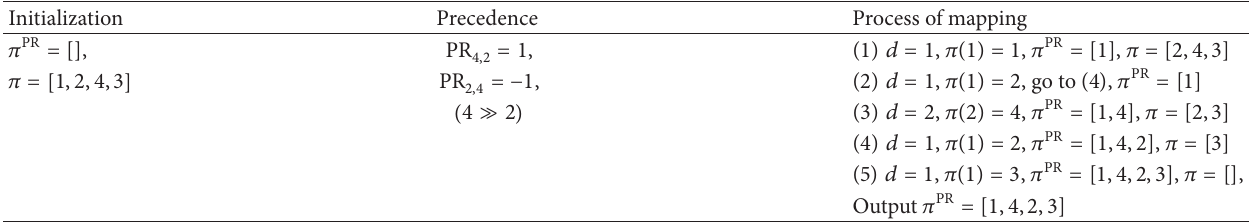
Table 2: Example of the mapping for obtaining the precedence-based